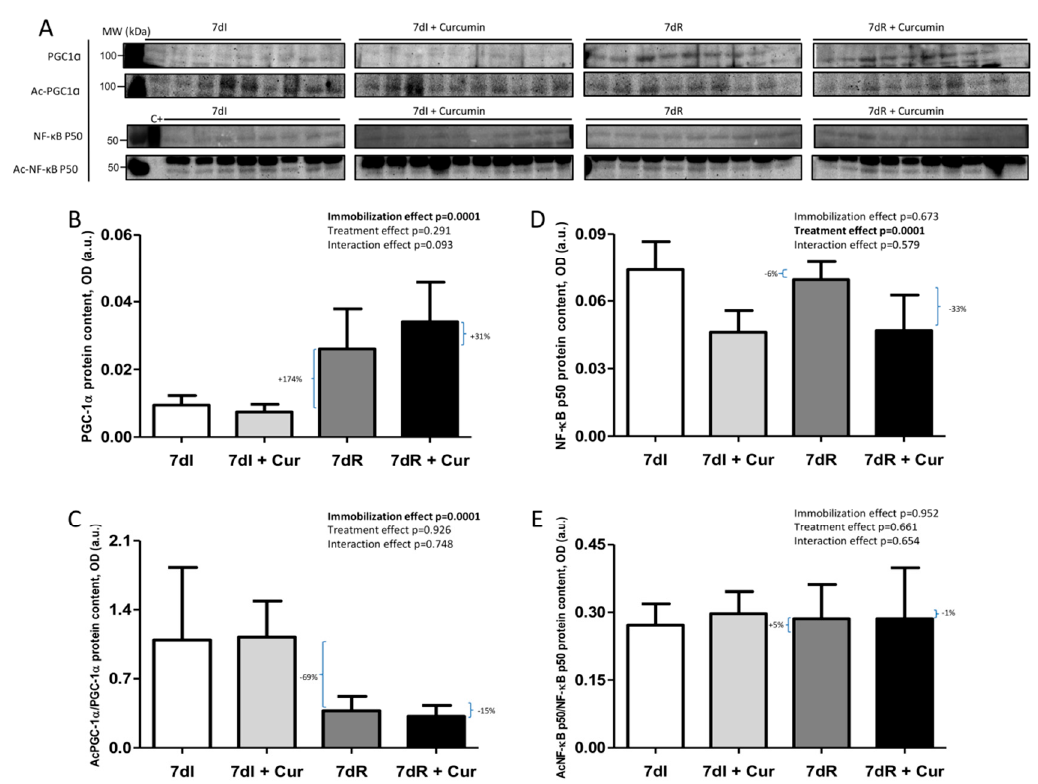
Figure 7. ( A ) Representative immunoblots of PGC-1 α , acetylated PGC-1 α , NF- κ B p50 and acetylated NF- κ B p50 proteins in the gastrocnemius muscle of all study groups of mice. Definition